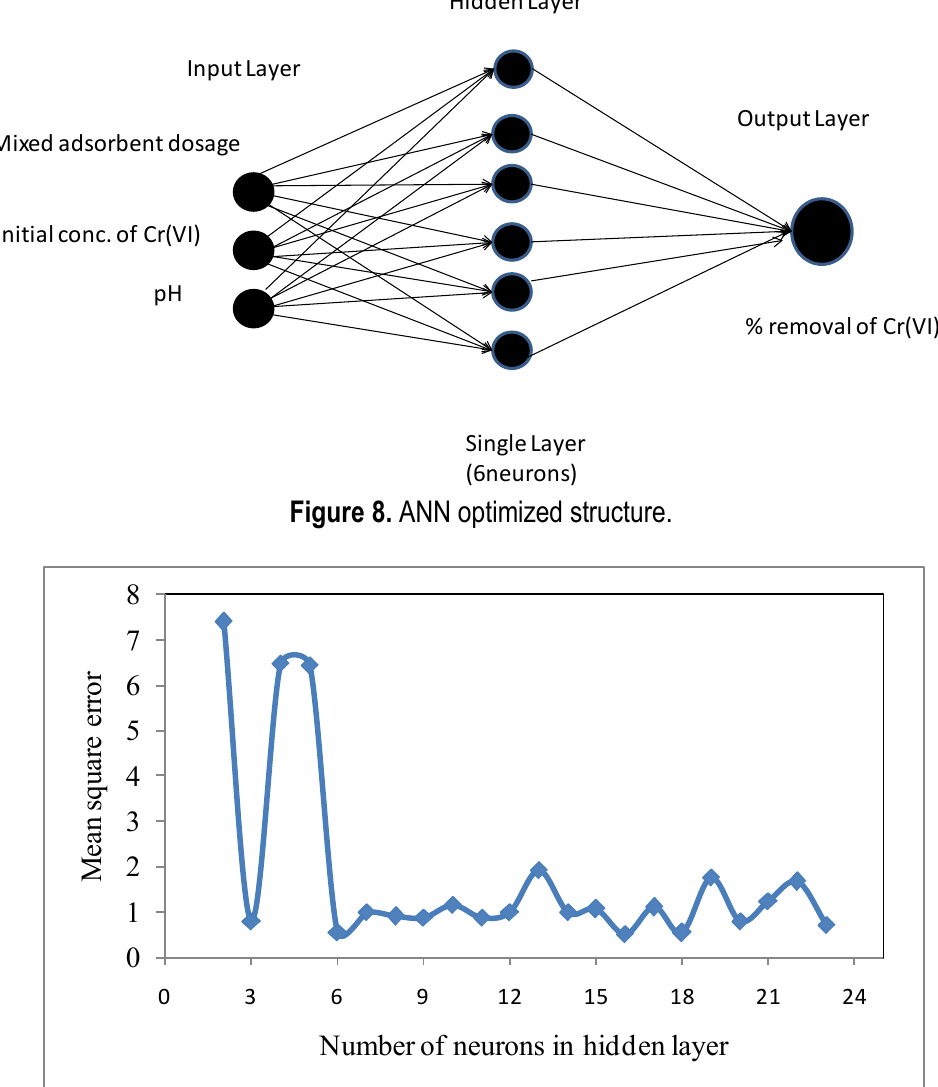
Figure 9. Mean Square Error versus number of neurons in hidden